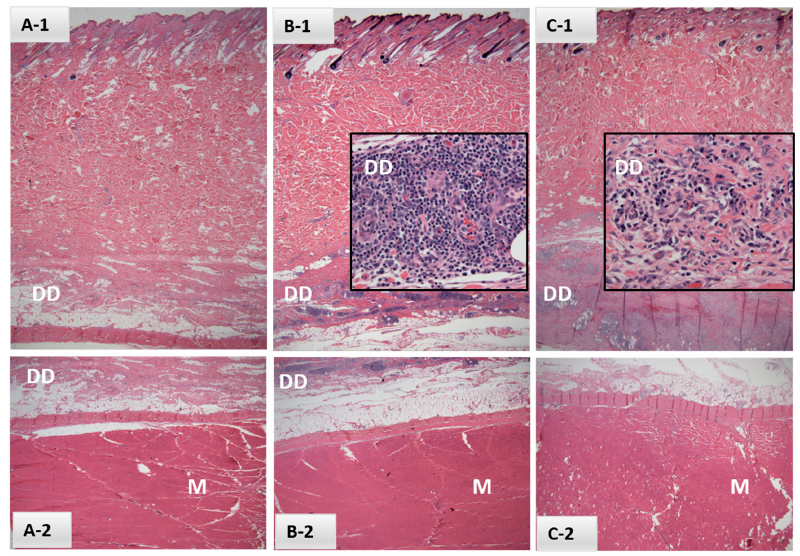
Figure 1. Histological sections of dermis ( A - 1 , B - 1 , C - 1 ), deep dermis (DD; A - 1 , B - 1 , C - 1 and A - 2 , B - 2 ) and underlying muscle (M; A - 2 , B - 2 , C - 2 ) from samples collected in Safety Study #1 from either control ( A ) or EBAA vaccine injection sites ( B , C ) at 21 days post-inoculation (H&E, 2 × ). Intervals between last palpable lesions and sample collection were ( B ) 14 days and ( C ) 1 day. Inserts ( B - 1 , C - 1 ) focus on perivascular mononuclear inflammatory cell infiltrates within the DD, consisting primarily of lymphocytes and plasma cells (40 ×